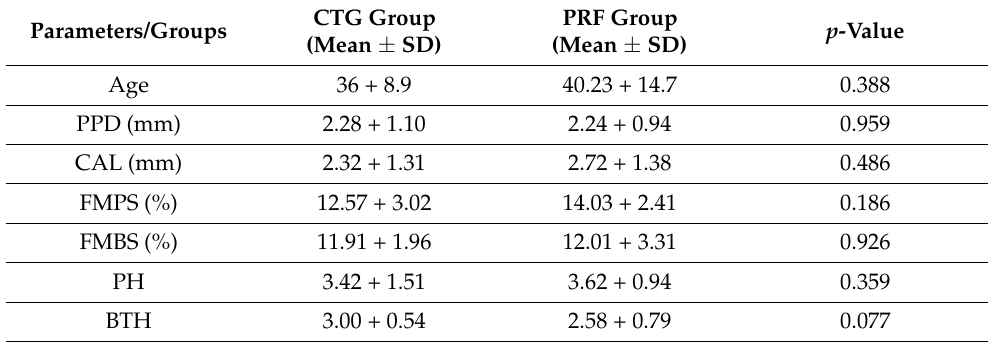
Table 1. Descriptive statistics of clinical parameters between the study groups.